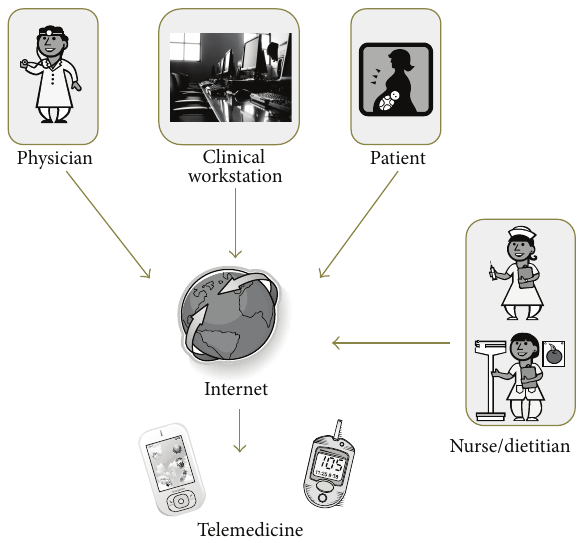
Figure 1: Schematic representation of the interconnection between patients, specialists, and technologies supported by